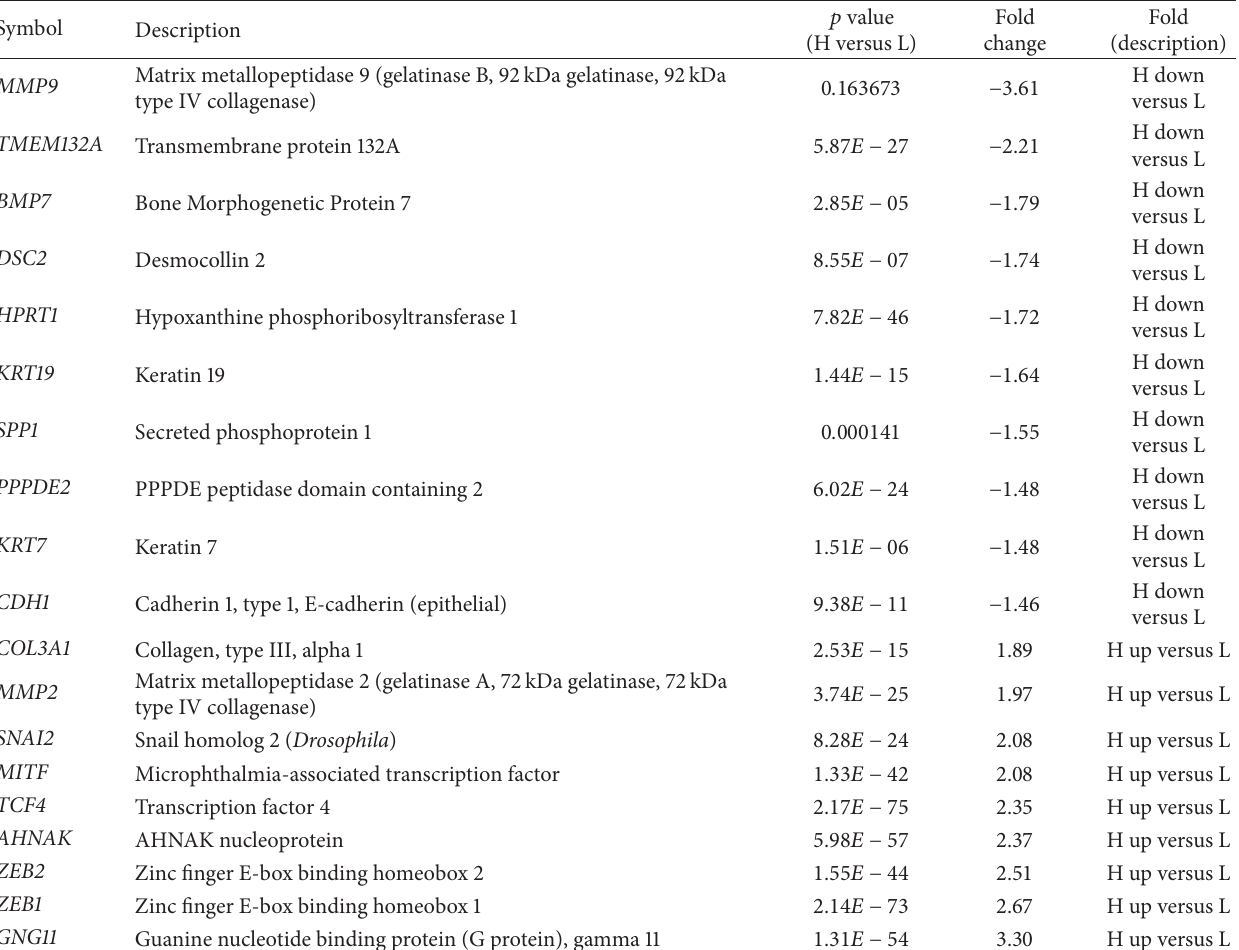
Table 3: Expression of top EMT-related genes in SEMA6D-H versus L